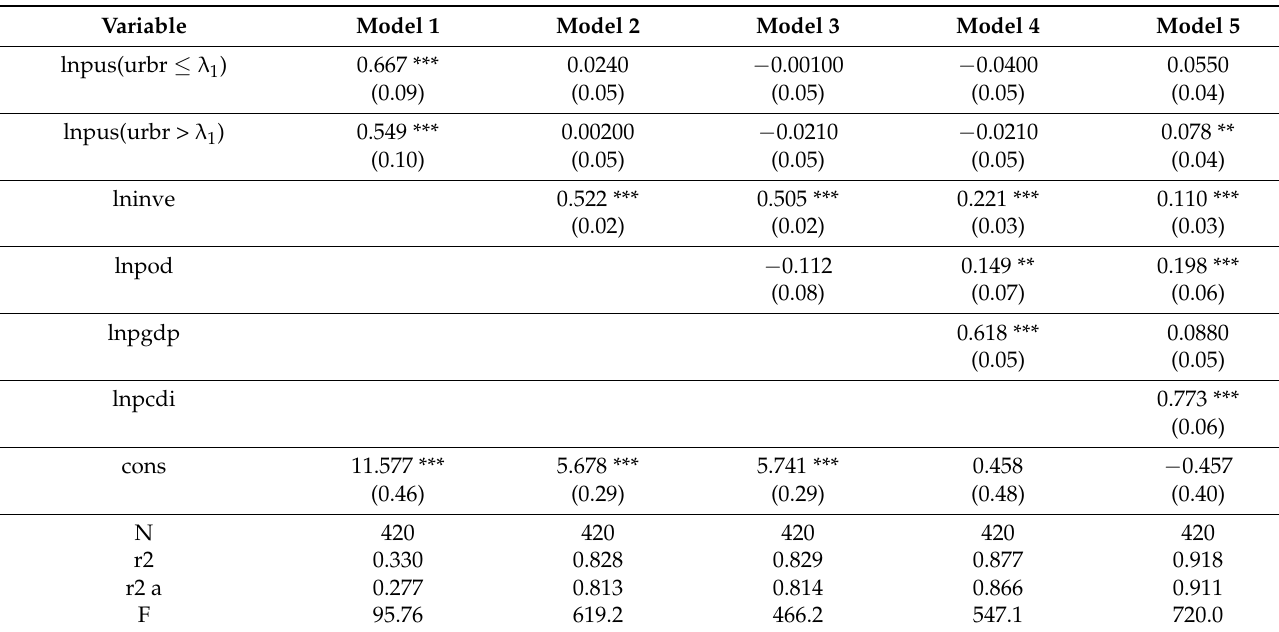
Table 6. Threshold egression results with URBR as the threshold